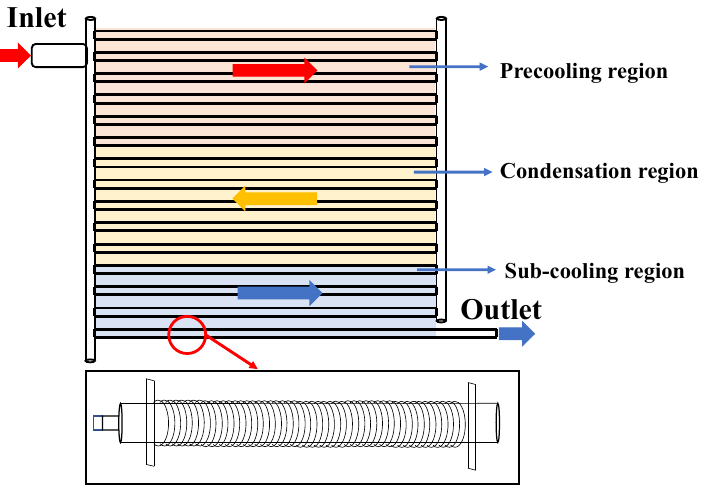
Figure 4. Structural schematic of fin − and − tube heat exchanger.